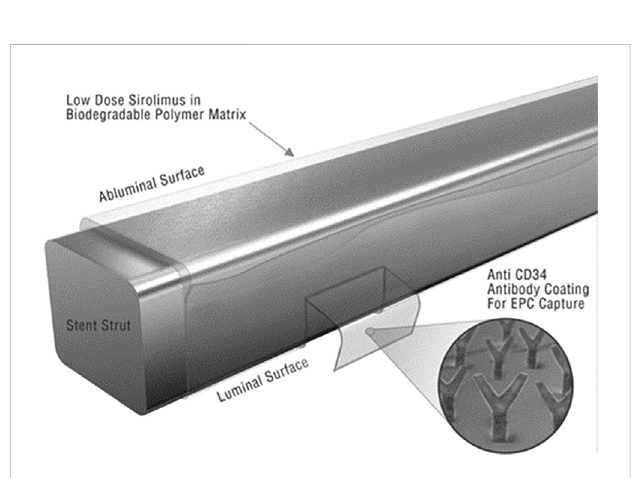
FIGURE 9 Surface functionalization of a stent by antibody coatings (Sethi and LEE, 2012) with permission of the Wiley Online